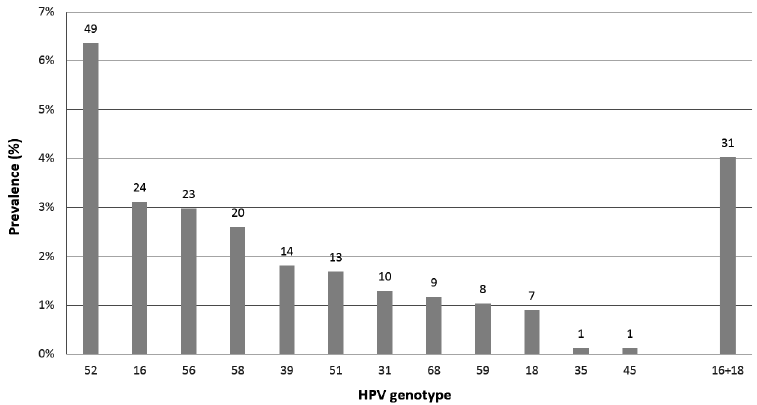
Fig 1. Prevalence of high-risk HPV by genotype among 770 sexually active subjects. Using the cervical specimens that participants had collected by themselves, HPV genotypes were analyzed using Hybrid Capture 2 assay (Digene/Qiagen) and GENOSEARCH HPV 31 (Medical & Biological Laboratories, Nagoya, Japan). Numbers on the x-axis indicate genotypes. The number on the top of the column indicates the number of women infected with high-risk HPV of the specific